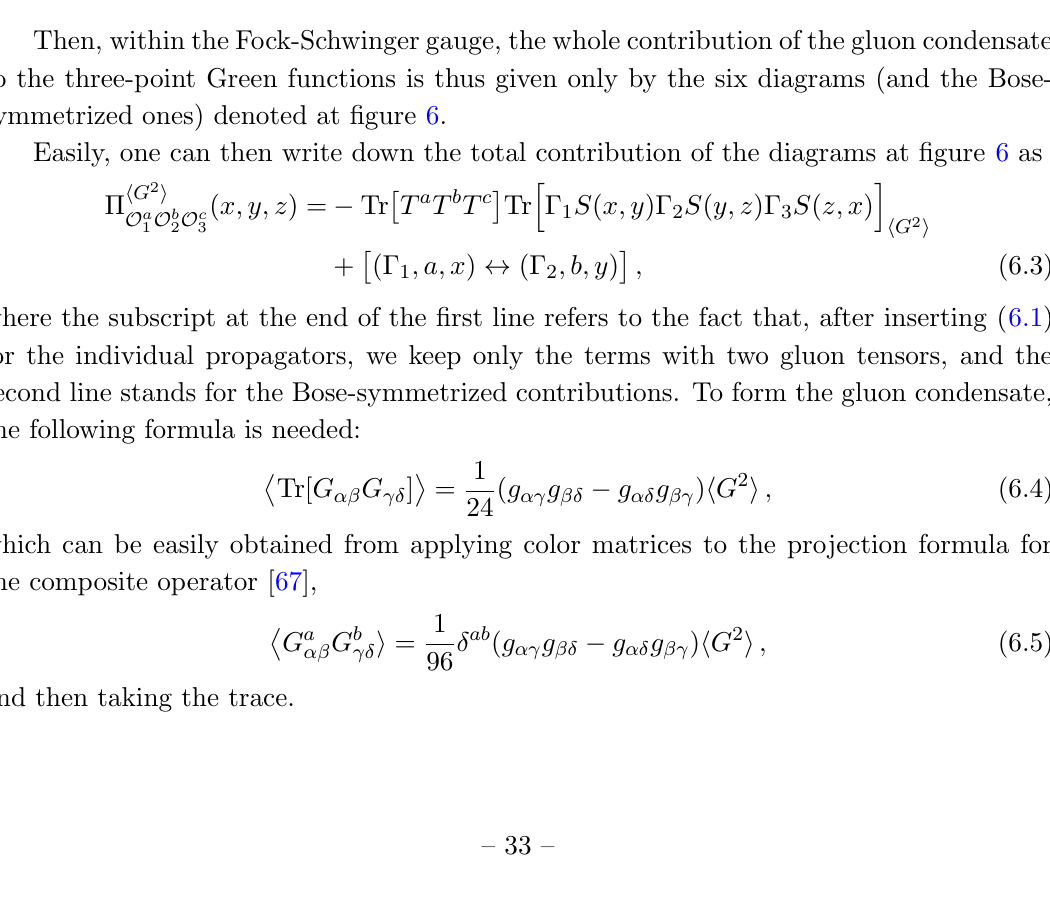
Figure 6. Feynman diagrams of the contributions of the gluon condensate to the three-point Green functions. Similarly as in (cid:12)gure 3, the Bose-symmetrized diagrams are tacitly assumed. The dia- grams 6(a){6(c) contain two propagators (6.2b) and the diagrams 6(d){6(f) one propagator